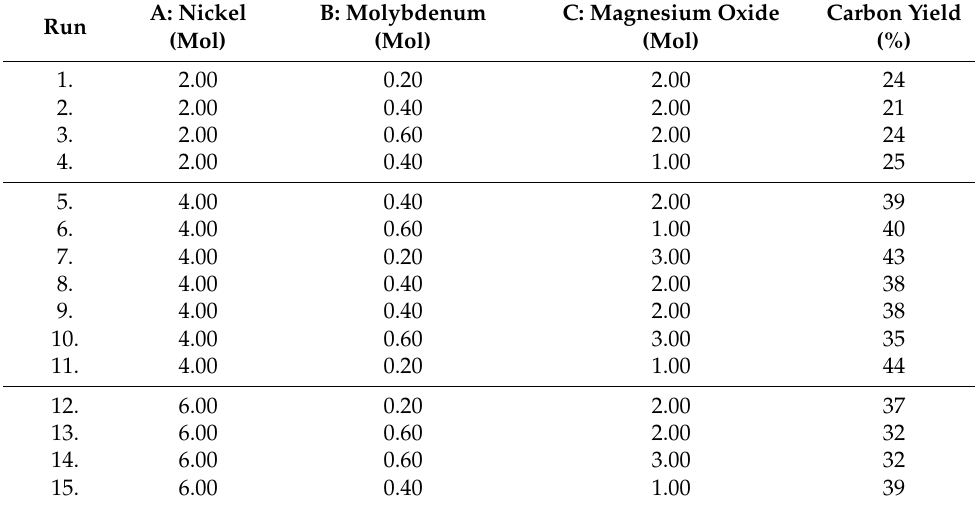
Table 3. Optimization of Ni/Mo/MgO concentrations in the catalyst.